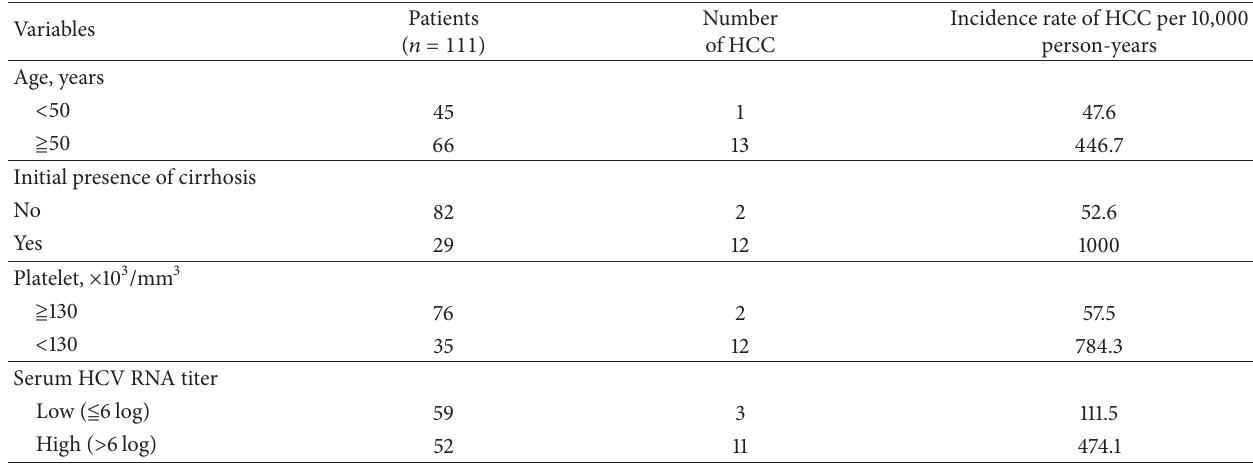
Table 3: Incidence rates of hepatocellular carcinoma per 10,000 person-years by significant